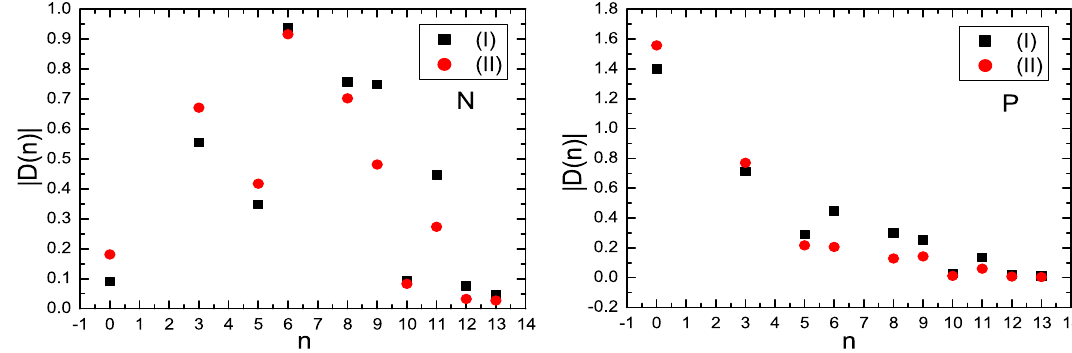
Fig. 1 The absolute contributions of the vacuum condensates of dimension n for central values of the parameters A , where the (I) and (II) denote the pentaquark states uuuc ¯ u and sssc ¯ s , respectively, the N and P denote the negative parity and positive parity pentaquark states,